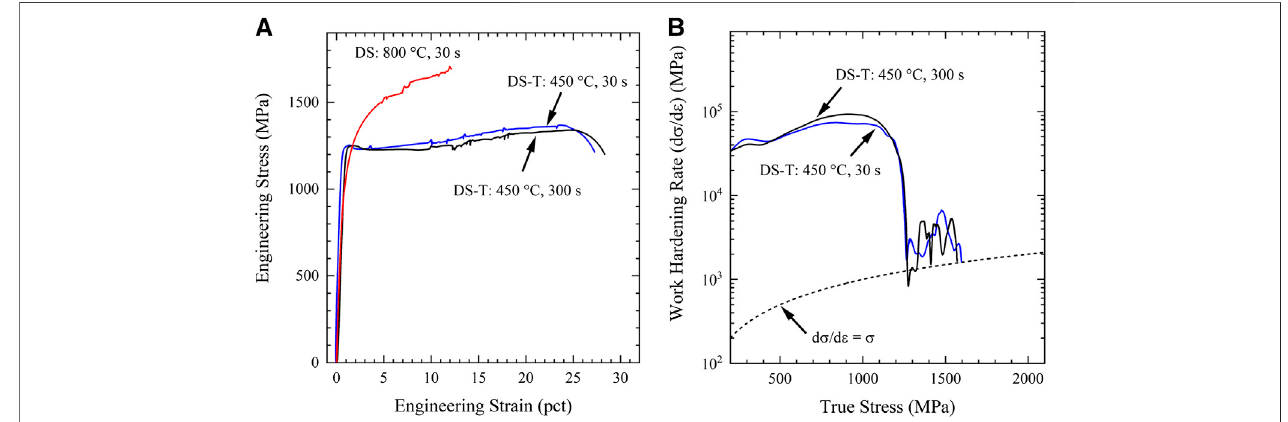
Frontiers in Materials |